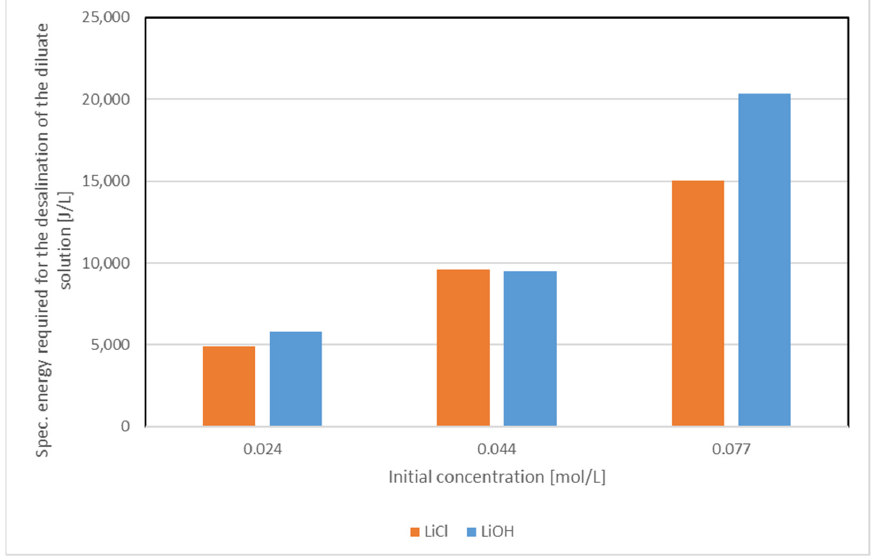
Figure 7. Comparison of the specific desalination energy required for varying molar concentrations of LiCl and LiOH solutions at ϑ = 21